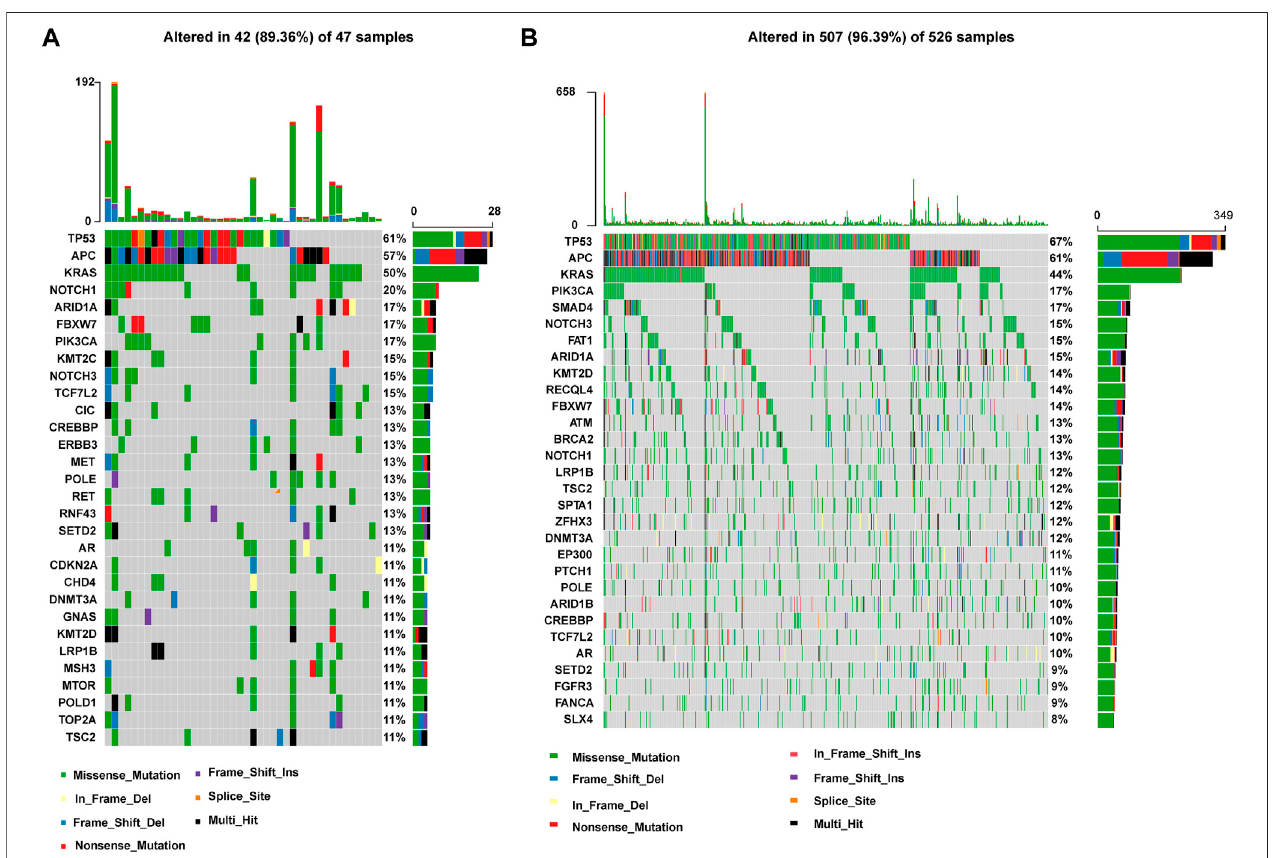
FIGURE 2 | Heatmap of full SNV and INDEL somatic mutation for patients with P/LP (A) or Non-P (B) germline mutations. (A) Somatic mutation spectrum for 47 patients with P/LP germline mutations. (B) Somatic mutation spectrum for 526 patients with Non-P germline mutations. Details of mutations are labeled beneath each panel, and somaticallymutatedgenesarelisted in theleftofthe fi gures. Theright bars represent theoverallnumber ofmutations foreach gene. Y -axis above each panel represents the number of somatic mutations detected for each patient. Colors represent mutation types as indicated by the fi gure legend.